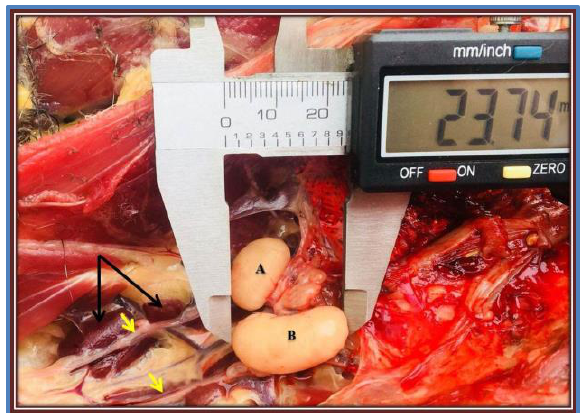
Figure,3: Gross appearance of celomic cavity of guinea fowl showing: right testis (A), left testis (B), right and left ductus deference (yellow arrow), kidney (black arrow)